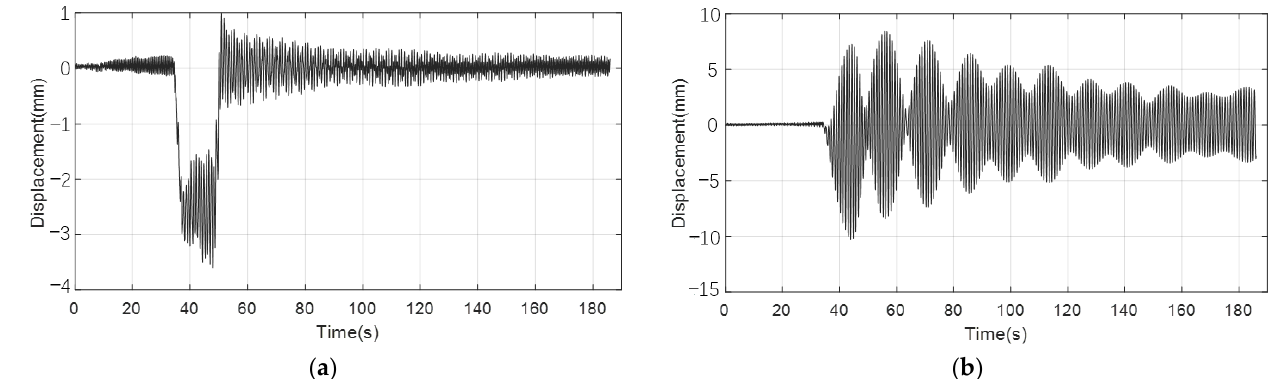
Figure 8. The cable displacements of the Hukun-Wuguang bridge, which ( a ) is the displacement of the nearest cable at 52.19 m and ( b ) is the displacement of the farthest cable at 67.02 m.